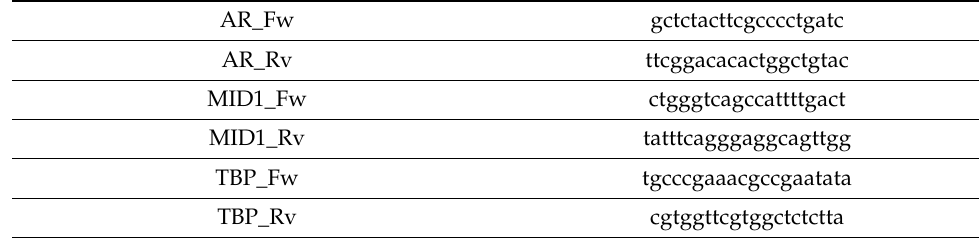
Table 2. Primer pairs used for